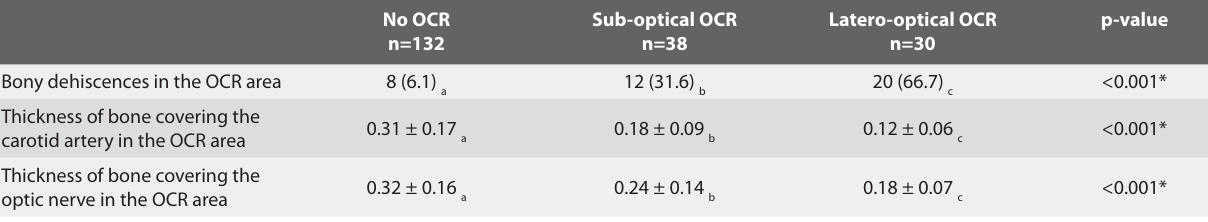
Continuous variables are presented as means ± standard deviations in mm. Categorical variables as absolute numbers and percentages (%). * repre- sents statistical significance at the Bonferroni-adjusted α-level. Each subscript letter (a, b, c) denotes a subset of optico-carotid recess (OCR) groups whose proportions do not differ significantly from each other at the adjusted significance level.